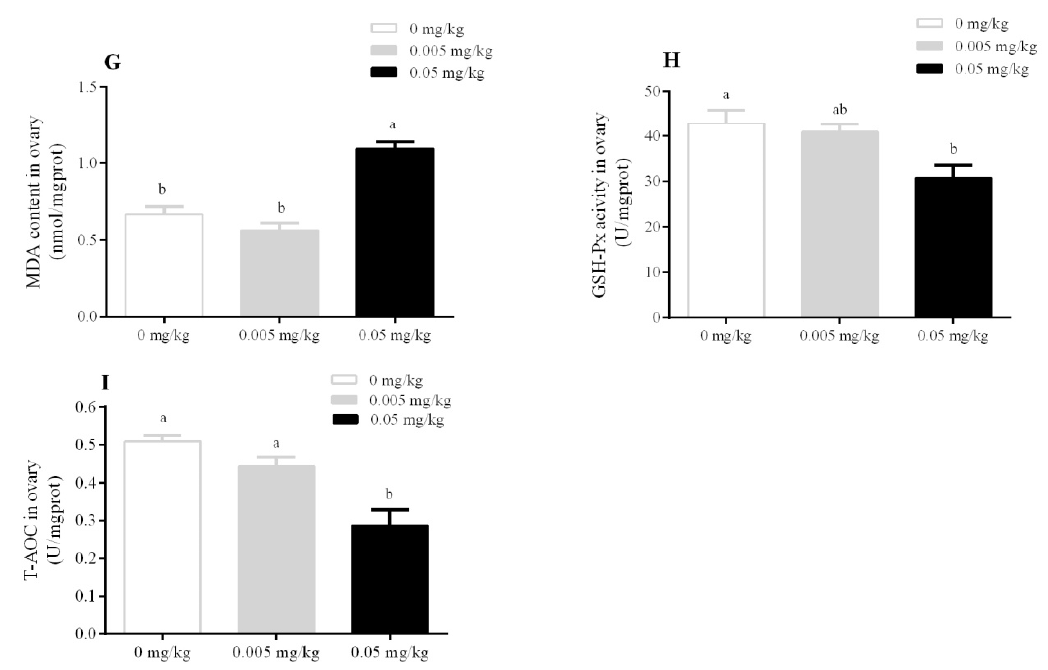
Figure 3. E ff ect of T-2 toxin exposure on antioxidant enzyme activity on lipid peroxidation content in the serum. ( A ) catalase (CAT), ( B ) superoxide dismutase (SOD), ( C ) malondialdehyde (MDA), ( D ) glutathione peroxide (GSH-Px). E ff ect of T-2 toxin exposure on antioxidant enzyme activity on lipid peroxidation content in the ovary, ( E ) catalase (CAT), ( F ) superoxide dismutase (SOD), ( G ) malondialdehyde (MDA), ( H ) glutathione peroxide (GSH-Px) ( I ) total antioxidant activity (T-AOC), of female mice whose dams were orally administered with T-2 toxin at 0, 0.005, and 0.05 mg / kg from gestational day 14 (GD 14) to lactational day 21 (LD 21). Each value represents the mean ± SEM of the group ( n = 5). Di ff erent letters indicate statistically significant di ff erences, p <